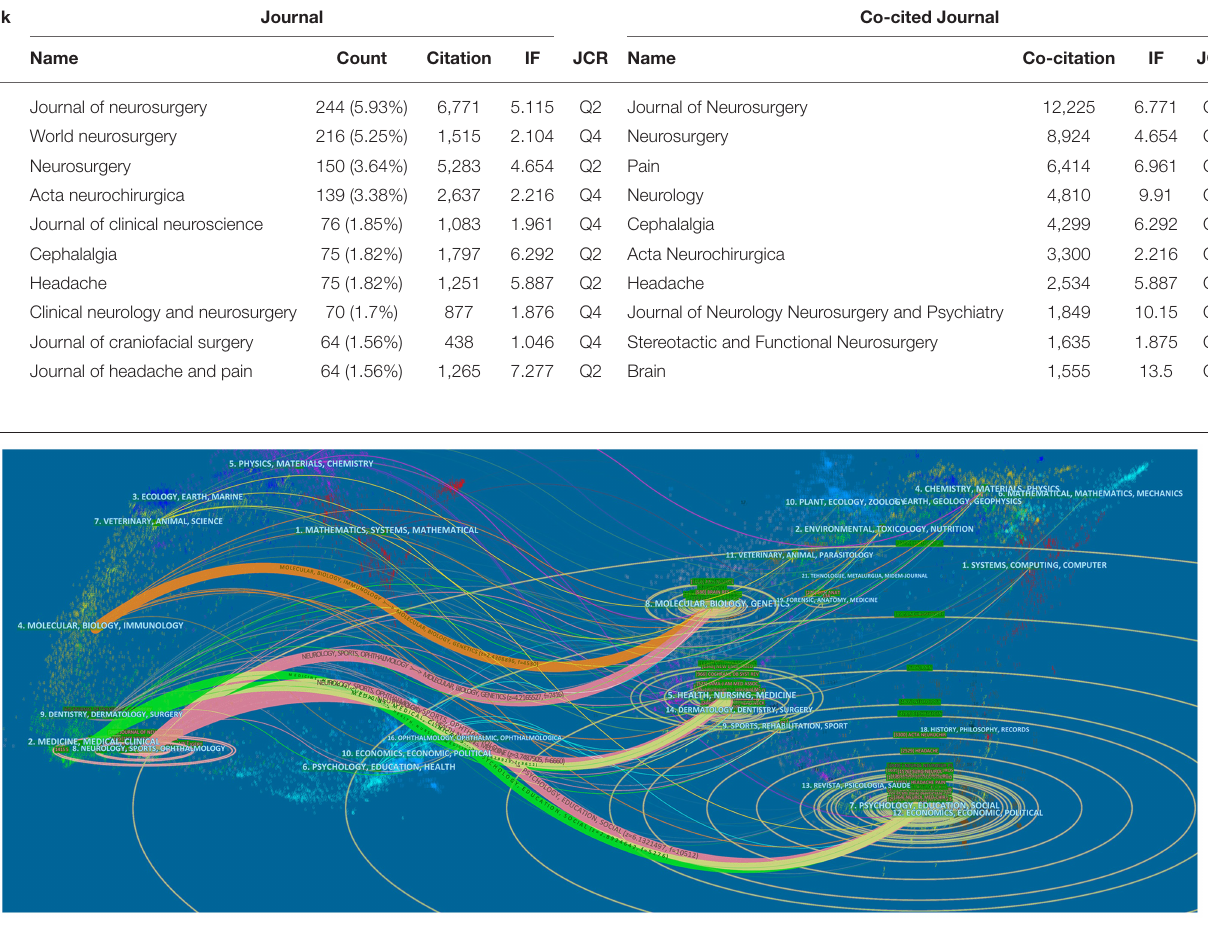
FIGURE 3 | The dural map overlay of journals on TN.